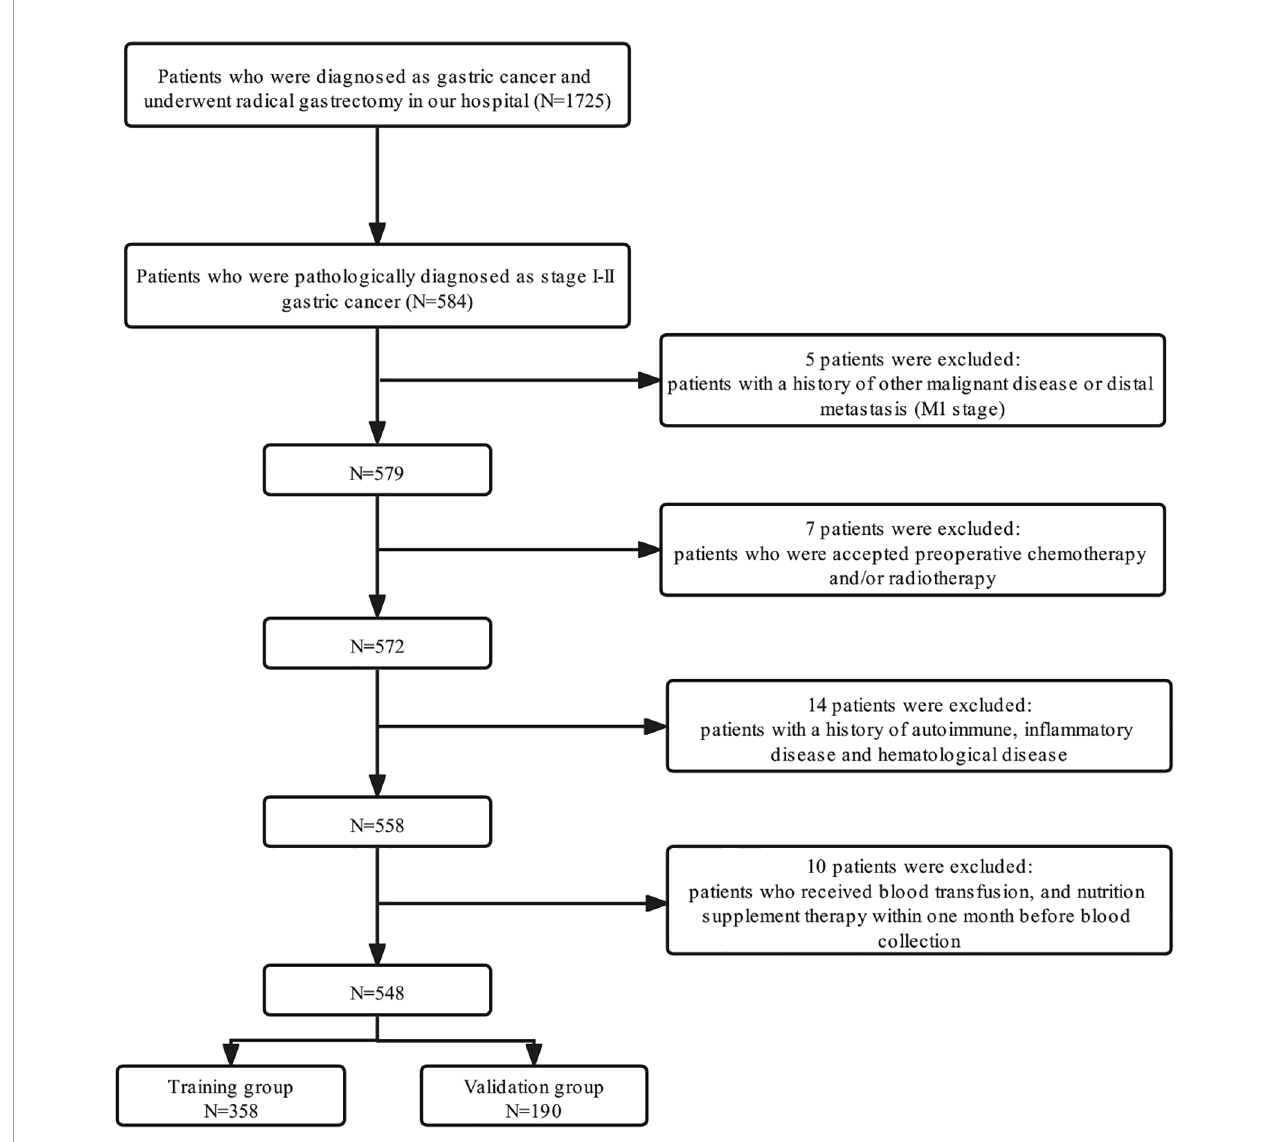
FIGURE 1 | Flow diagram of the patient selection